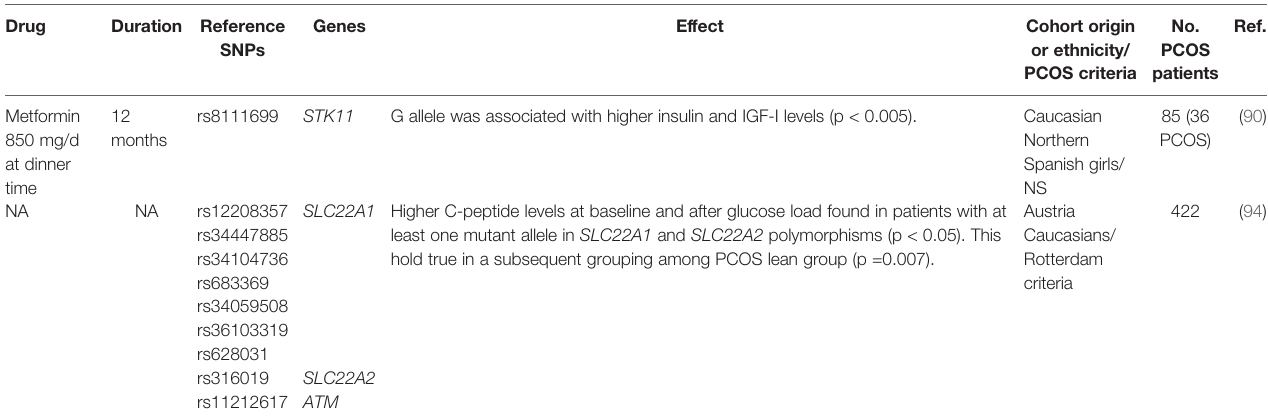
TABLE 3 | Single nucleotide polymorphism associated with traits before drug ingestion. Drug Duration Reference SNPs